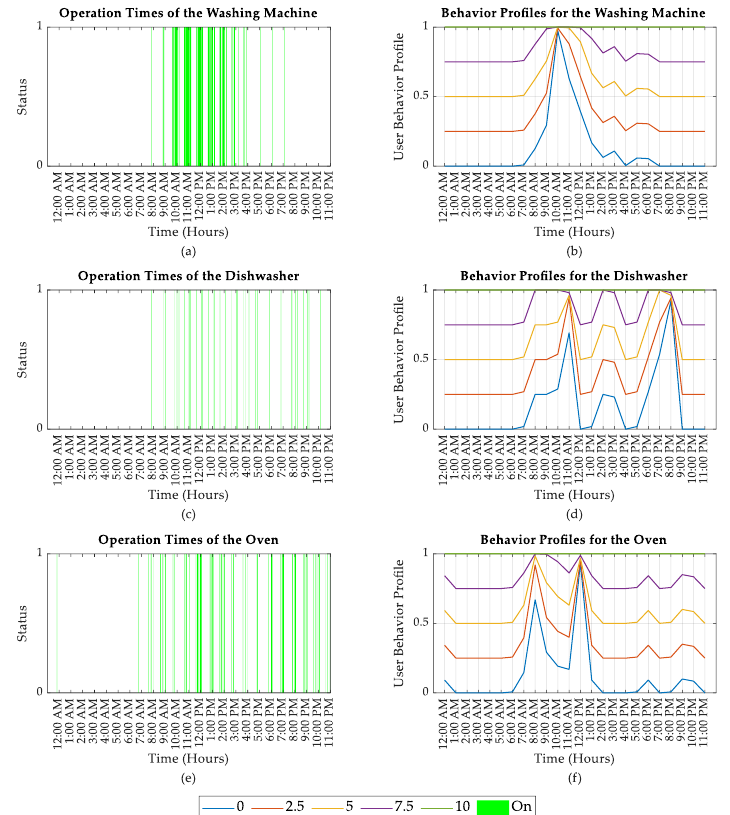
Figure 1. Operation times and behavior profiles for each shiftable appliance. ( a ) Operation times of the washing machine; ( b ) User behavior profile of the washing machine; ( c ) Operation times of the dishwasher; ( d ) User behavior profile of the dishwasher; ( e ) Operation times of the washing machine; ( f ) User behavior profile of the washing machine.